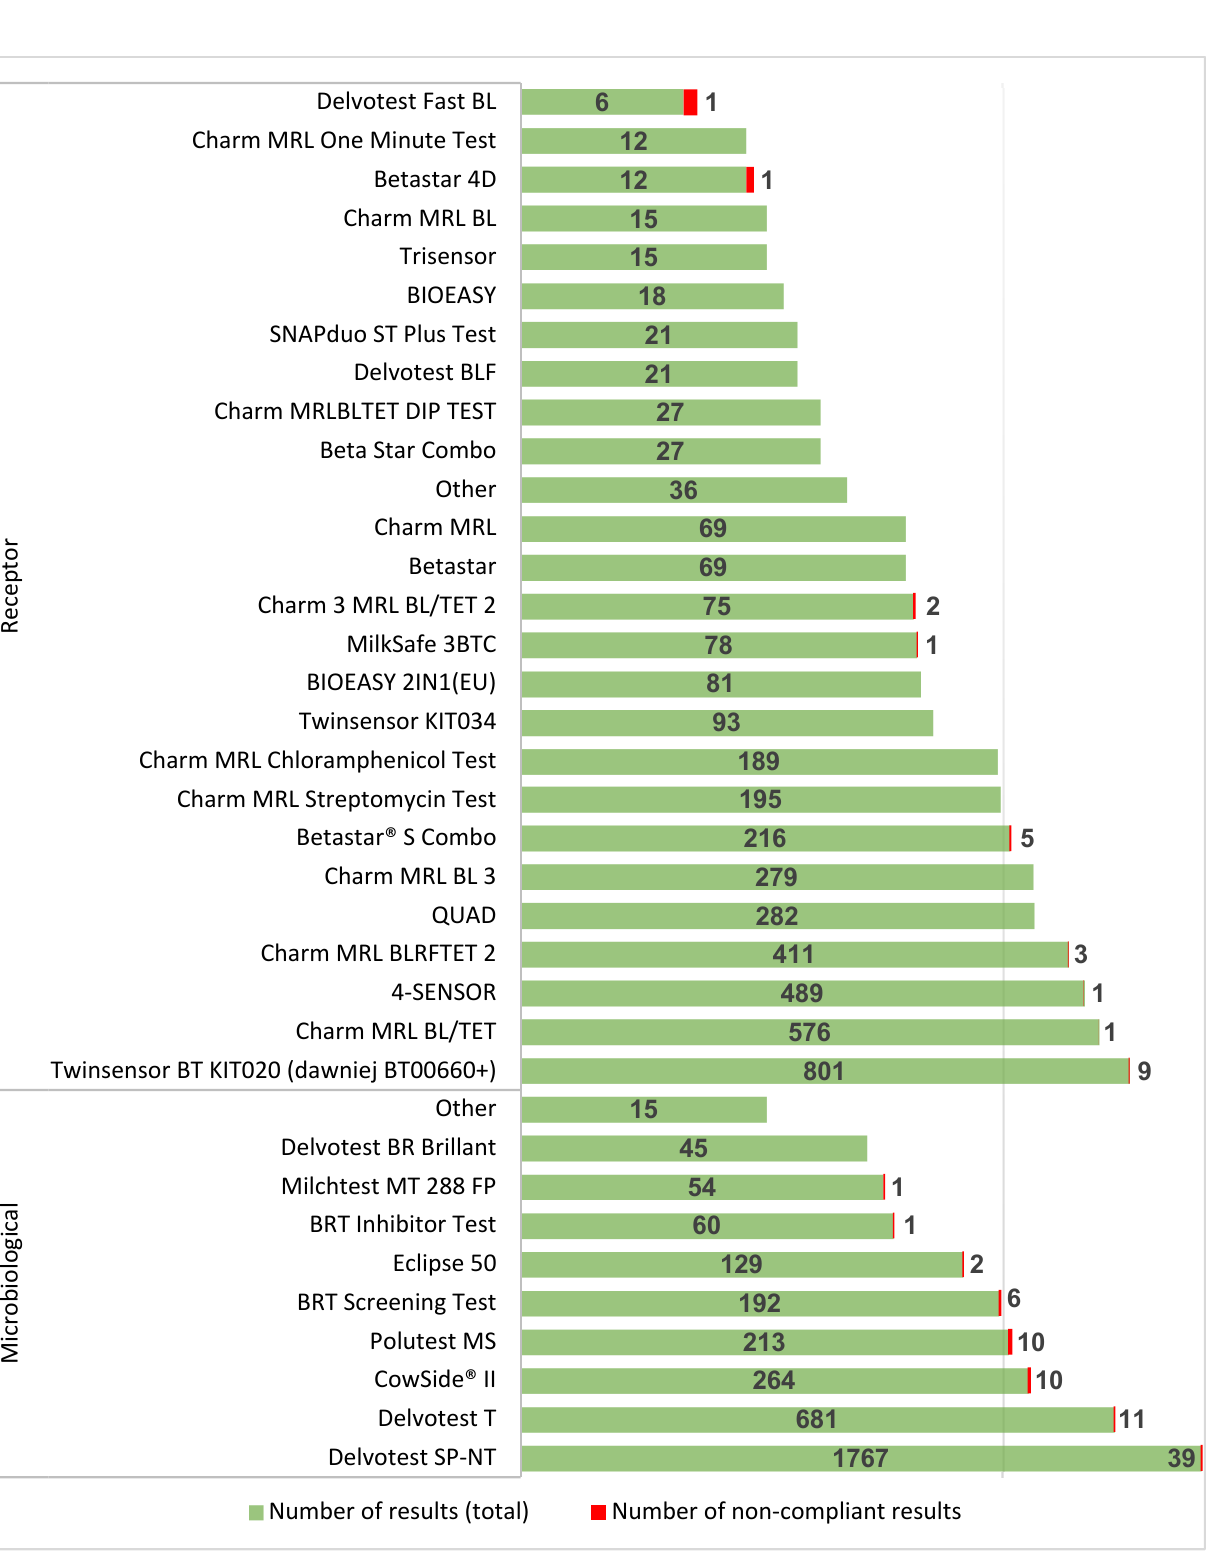
Figure 2. Microbiological and receptor test results by the test product with indications of the number of non-compliant results in 2017–2021.